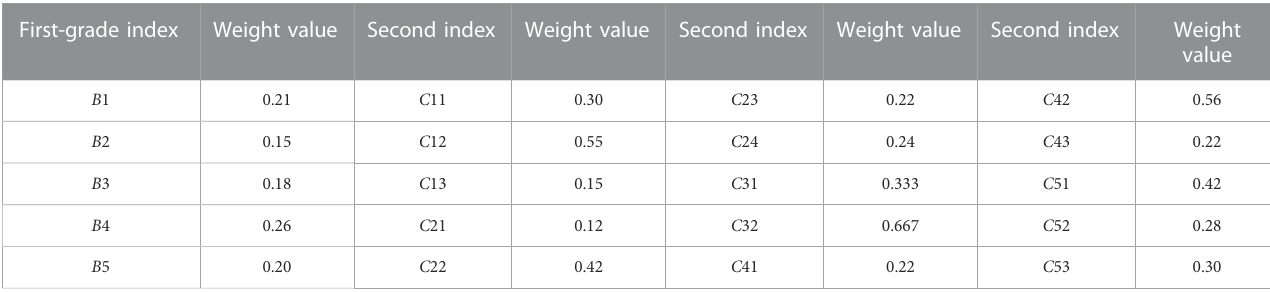
TABLE 4 Weights of all levels ’